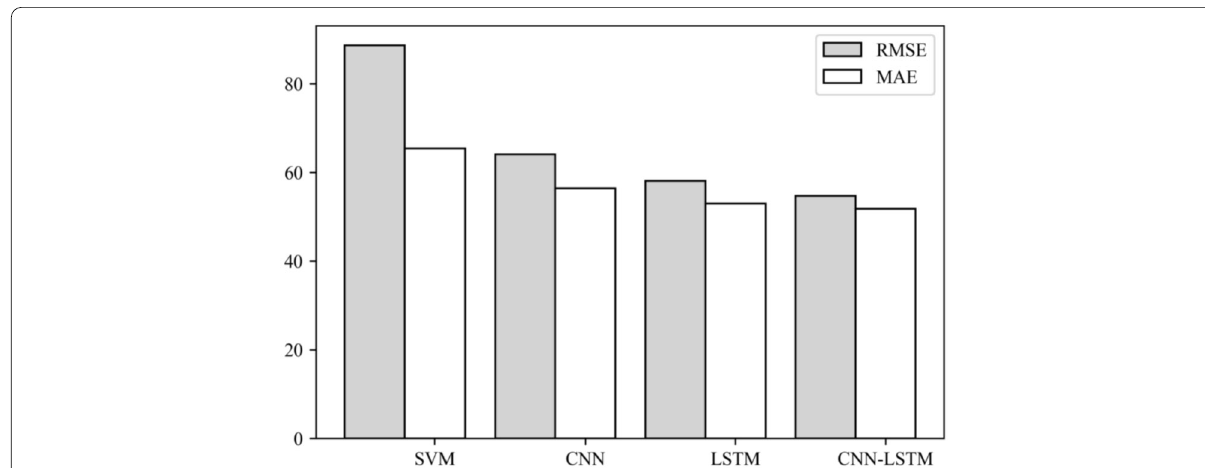
Figure 6 The modelling results of different algorithms based on feature extraction